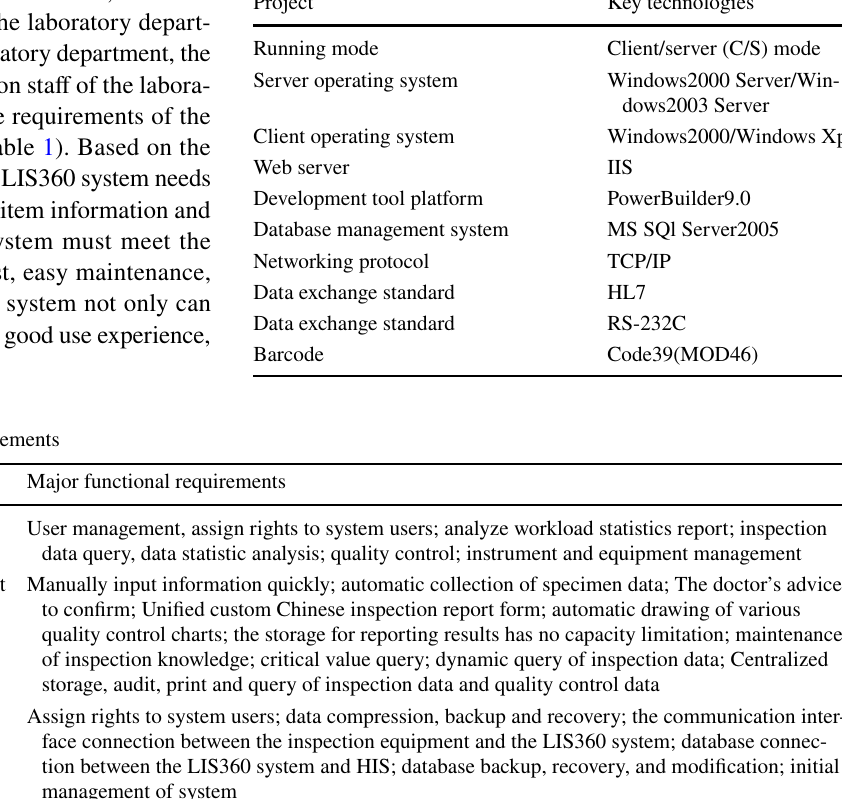
Table 2 Key technology selection table Project Key